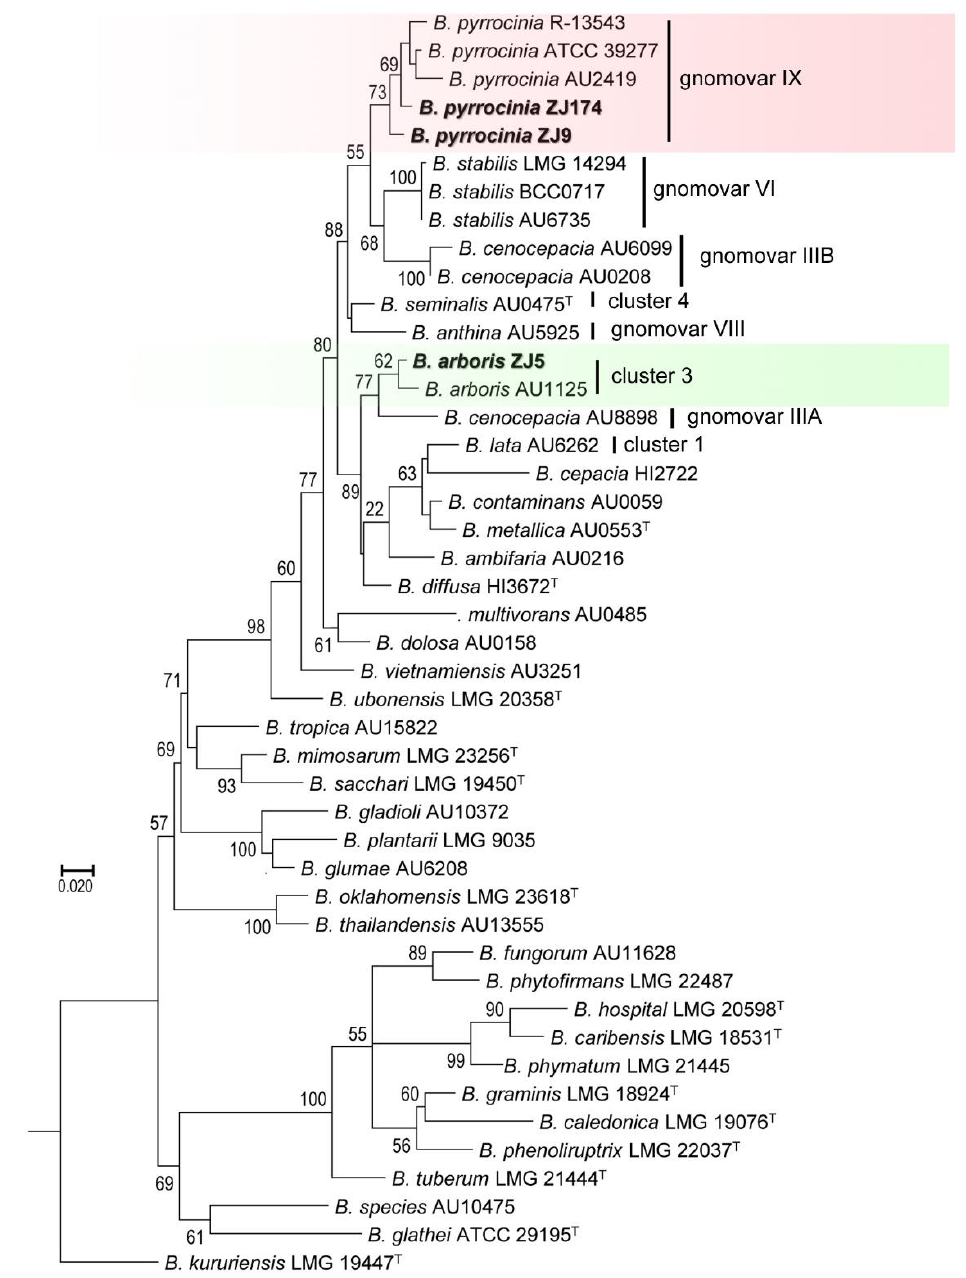
Figure 8. Phylogeny of Burkholderia species strains were constructed in this study with RaxmlGUI v. 1.5 using the maximum likelihood method based on the recA gene sequences. The reference sequences of each species were downloaded from the Burkholderia cepacia complex multilocus sequence typing website (http://pubmlst.org/bcc/; accessed on 26 August 2021). Percentage bootstrap values >50% from 1000 samplings are indicated. B. kururiensis strain LMG 19447 T was used as an outgroup. Strains isolated from soil in this study are shown in bold. Type strain was indicated with T.